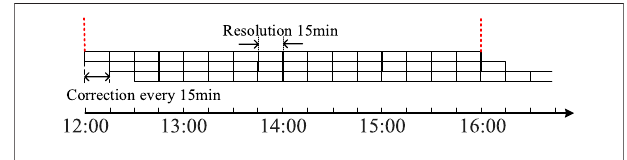
FIGURE 2 | Intraday scheduling sequence